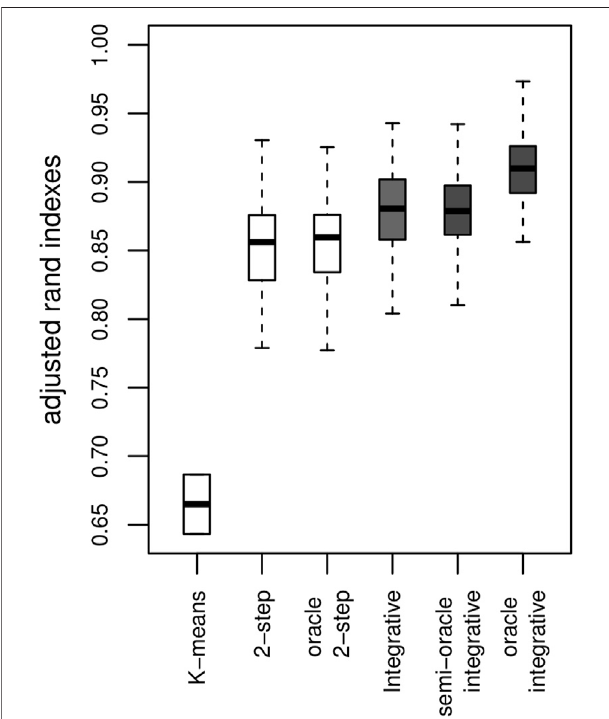
FIGURE 1 | Results on arti fi cial data over 100 simulations. ARI with a K - means algorithm, the 2-step method (no use of genetic information) and the integrative method (use of genetic information) and their corresponding oracles. The y -axis represents the ARI score (the higher the better).